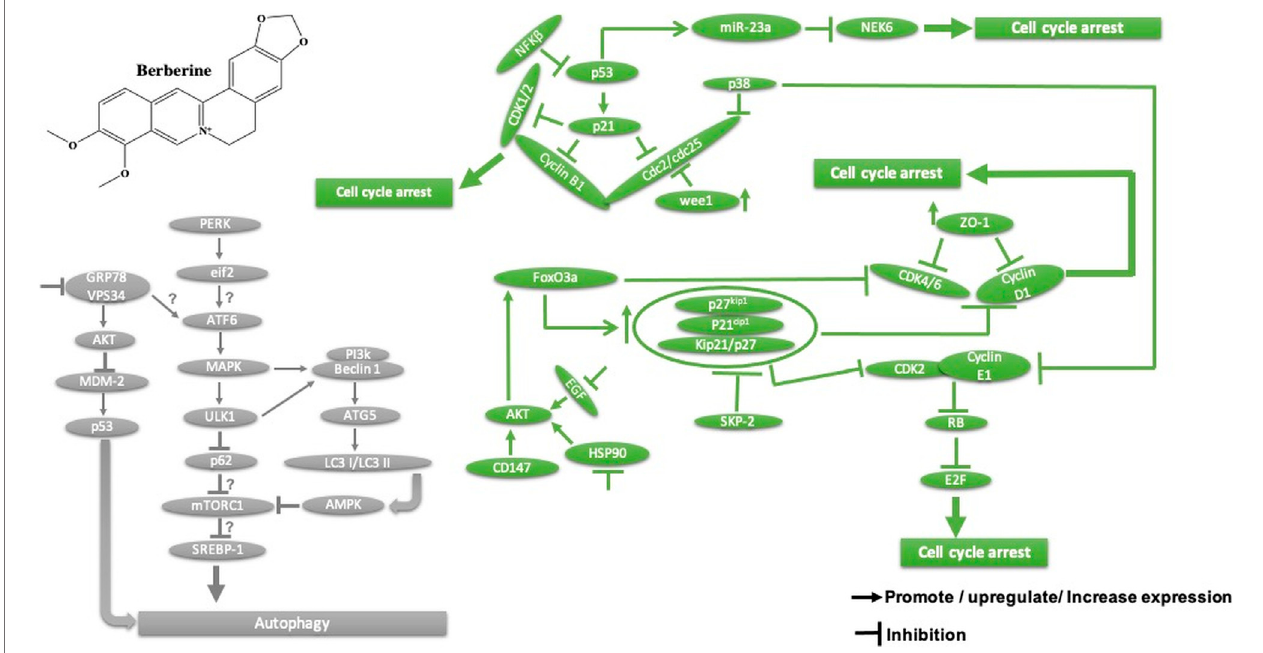
FIGURE 10 | Overview of the main molecular mechanisms of berberine-induced autophagy and cell cycle arrest.